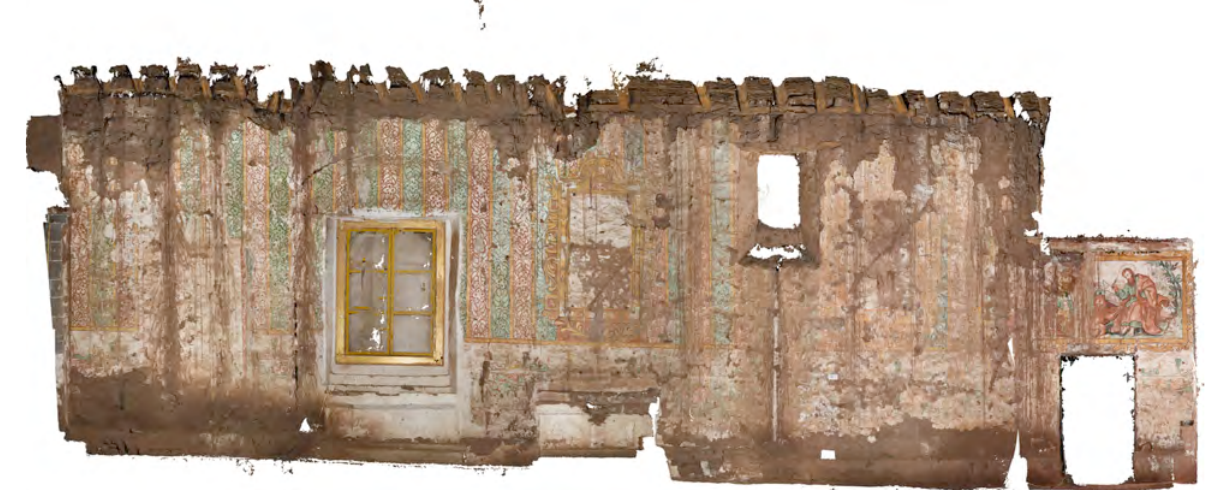
Figure 6. South façade, orthographic elevation of frescos generated from a photogrammetric